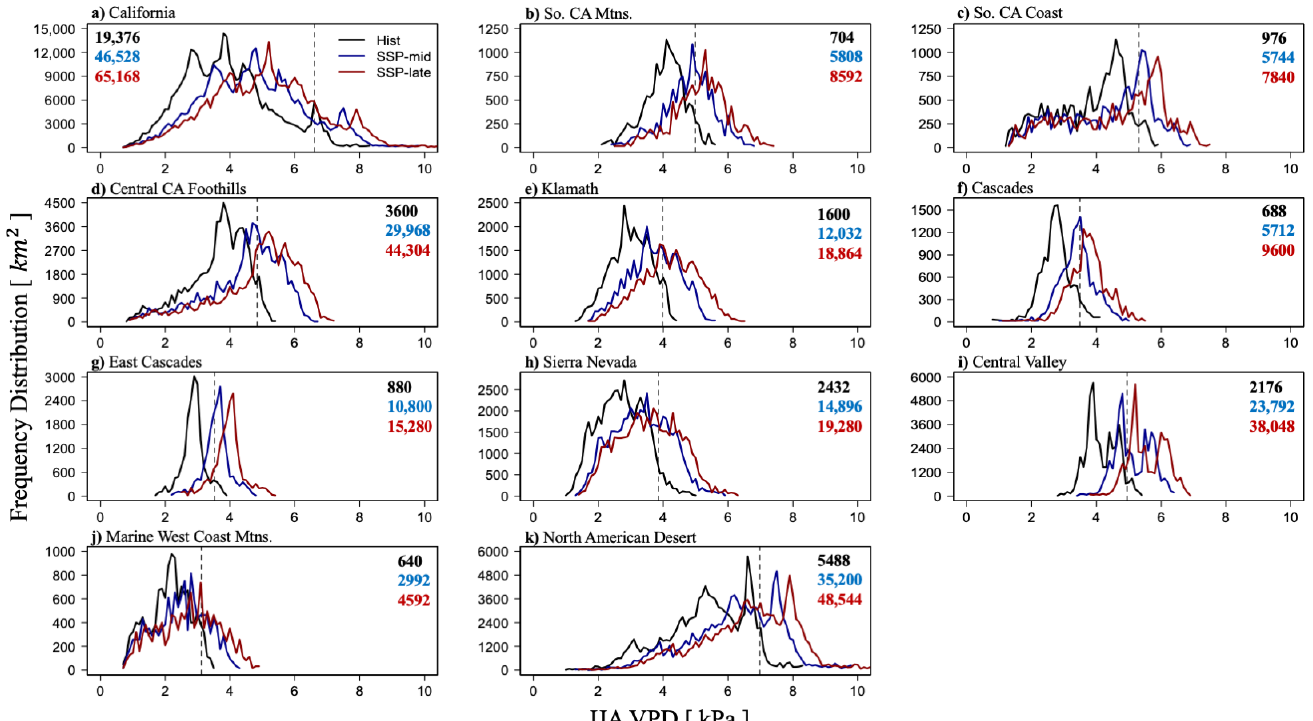
Figure 9. Frequency distribution depicting the area experiencing particular JJA VPD values. The dashed line represents the ecoregion specific 30 year average spatial 95th percentile value. The black, blue, and red lines represent the historical, mid-century, and late-century time periods, respectively. The color-coded text are areal units (km 2 ) experiencing greater than the 95th percentile value for that ecoregion. ( a ) California; ( b ) Southern California Mountains; ( c ) Southern California Coast; ( d ) Central California Foothills; ( e ) Klamath; ( f ) Cascades; ( g ) East Cascades; ( h ) Sierra Nevada; ( i ) Central Valley; ( j ) Marine West Coast Mountains; ( k ) North American Desert.